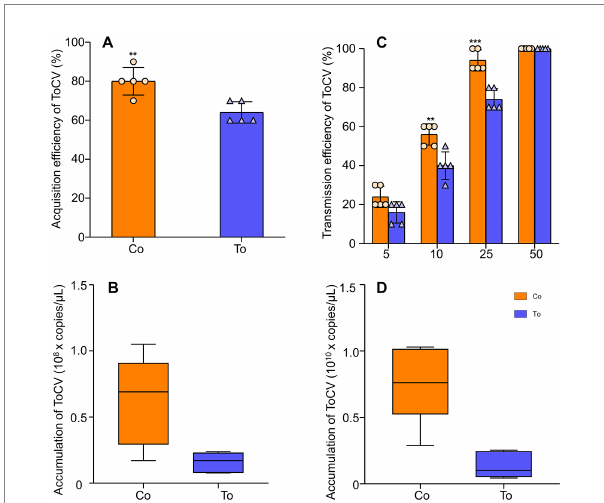
FIGURE 2 The expression of ToCV and the ability of Bemisia tabaci MED to acquire and transmit virus. (A) Acquisition rate in B. tabaci MED. (B) ToCV accumulation in B. tabaci MED. (C) Transmission rate in B. tabaci MED. The horizontal axis shows the number of B. tabaci MED to transmit ToCV. (D) ToCV accumulation in tomato plants. Co, co- infected B. tabaci MED; To, ToCV-infected. Data are denoted as mean ± SE. *** indicates a significant difference at p < 0.001; ** indicates a significant difference at p < 0.01; * indicates a significant difference at p <